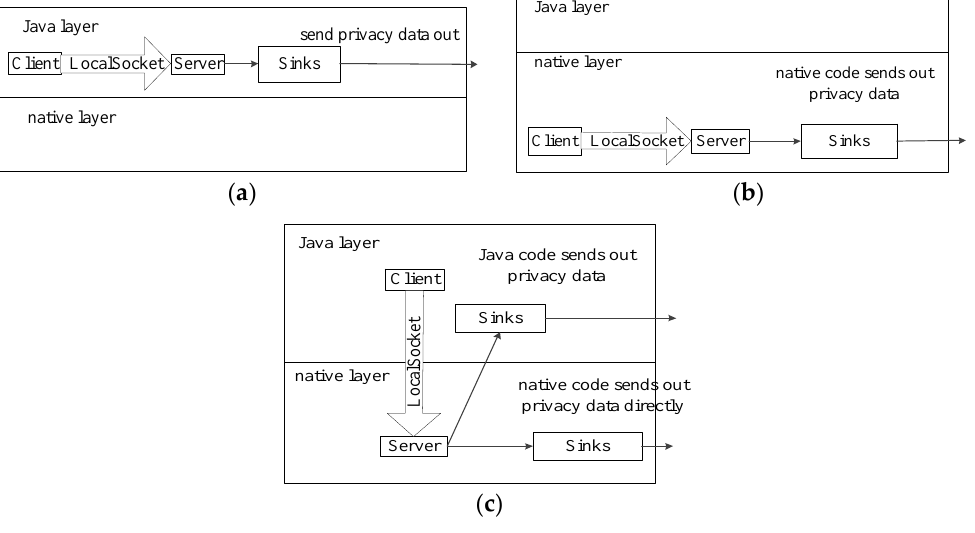
Figure 3. Examples of private data leakage through Unix domain sockets. ( a ) Case 1; ( b ) Case 2; ( c ) Case 3.